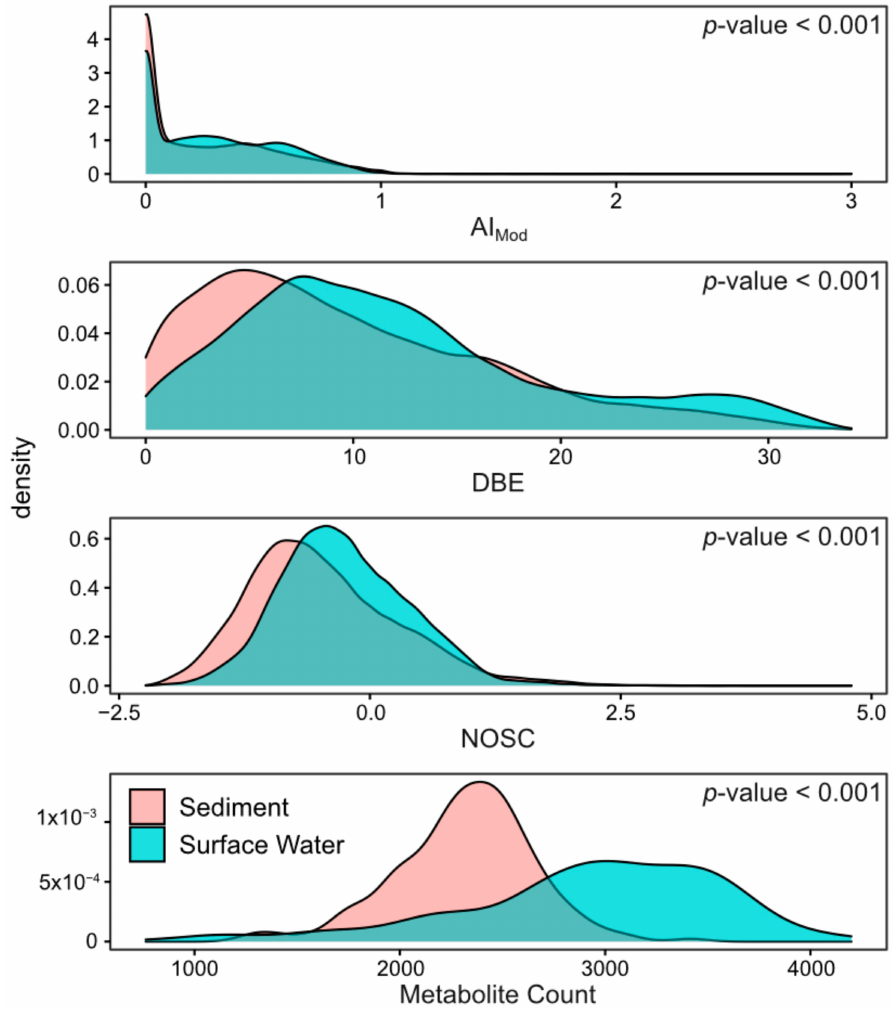
Figure 1. Density plots comparing the properties of all molecular formulas found in surface water and sediment samples. AI Mod (modified aromaticity index) is a measure of the potential ring-like structure in a given molecular formula. DBE (double-bond equivalents) is an approximation of potential unsaturation. NOSC (nominal oxidation state of carbon) represents the degree of oxidation / reduction of a given molecular formula. Significance values obtained via a two-sided Mann-Whitney U test to compare sample type distributions are denoted in the upper right corner of each